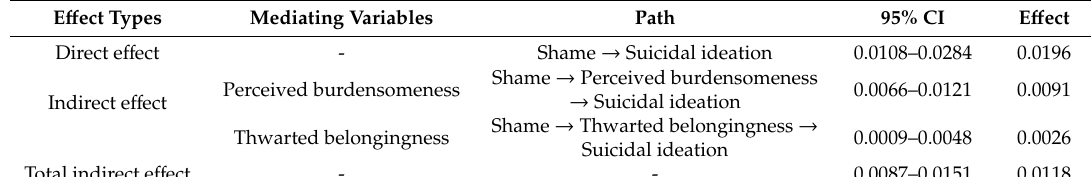
Table 4. Mediating e ff ects of perceived burdensomeness and thwarted belongingness between shame and suicidal ideation by process.